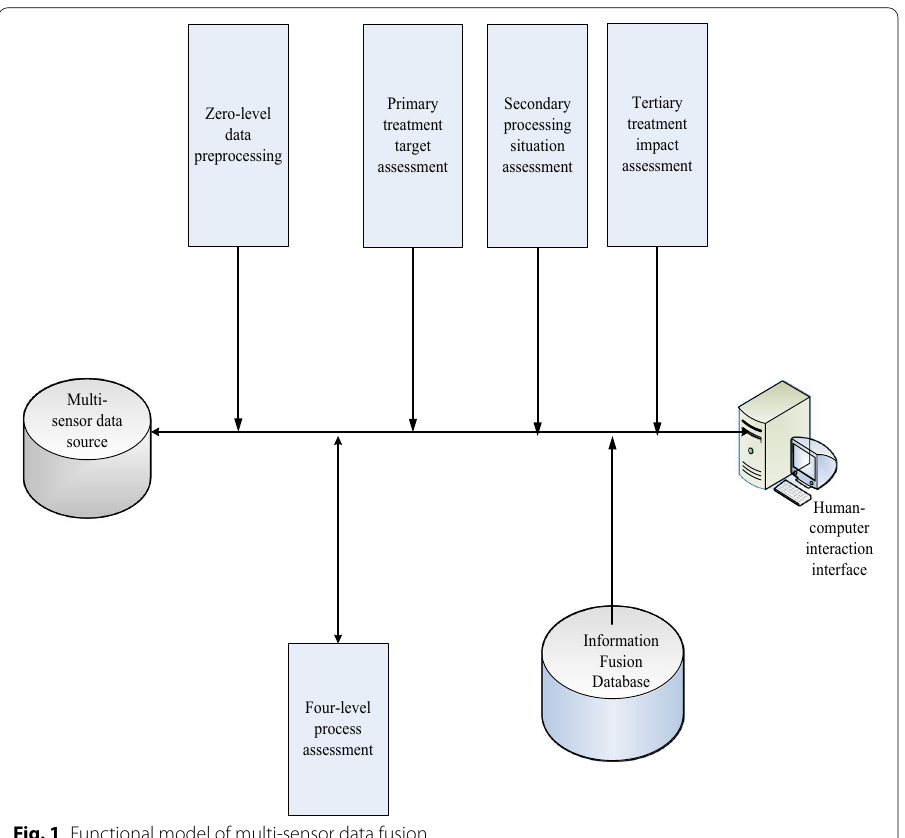
Fig. 1 Functional model of multi-sensor data